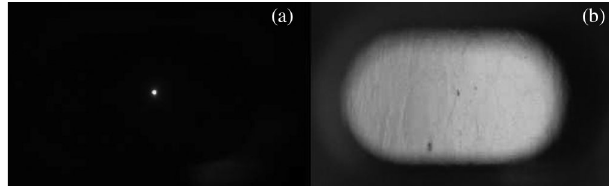
FIG. 7. The Faraday cup signal in amperes of a single- breakdown event (left) and a multiple-breakdown event (right). (a),(b) Before deconvolution. (c),(d) After